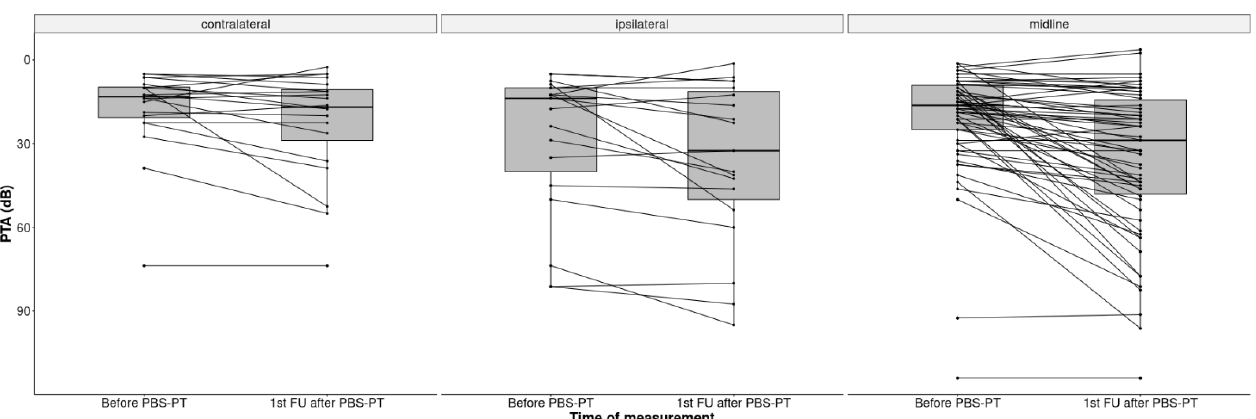
patients with lateralized tumors (32.5 dB HL) than in patients with midline tumors (28.9 lateralized tumors (32.5 dB HL) than in patients with midline tumors (28.9 dB HL) (Figure 3).